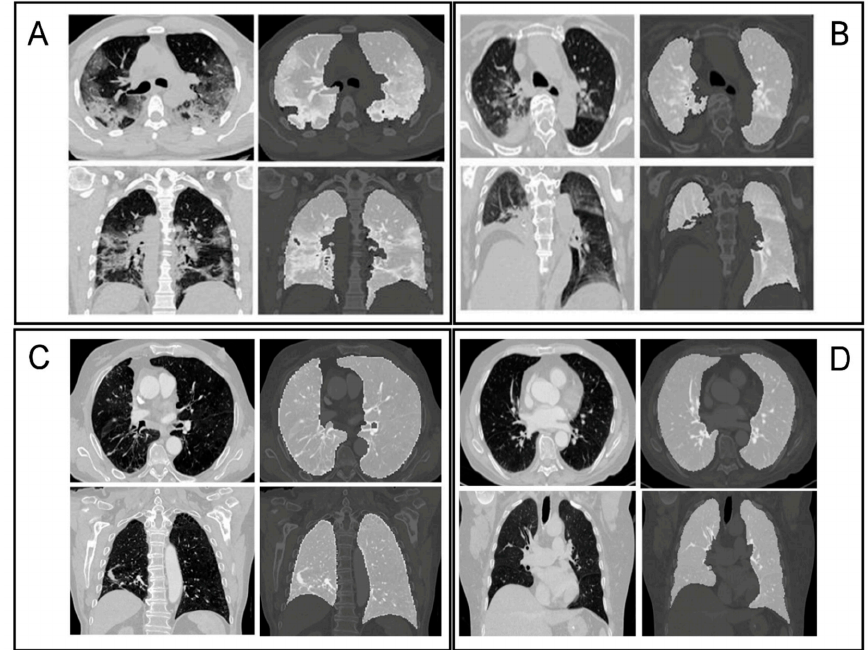
Figure 2. Axial and coronal slices with accompanying segmentation masks. ( A ) Typical aspect of COVID-19 pneumonia characterized by bilateral multilobe ground-glass opacities of periph- eral/subpleural distribution, with intralesional reticulations, presenting a “crazy paving” aspect. Subpleural atelectasis and retraction bronchiectasis, typical of organizing pneumonia can also be found; ( B ) a typical aspect of COVID-19 pneumonia, with posterior right lower lobe condensation and retraction of the ipsilateral diaphragm. Central and peripherical ground-glass opacities in right lower lobe, right upper lobe and left upper lobe; ( C ) typical chronic obstructive pulmonary disease (COPD) chest computed tomography (CT) characterized by severe centrilobular and para-septal emphysema, associated with cylindrical bronchiectasis and bronchial walls thickening. Right peripherical upper lobe tree in bud pattern seen in bronchiolitis. Middle lobe crescent-shaped atelectasis condensation; ( D ) normal chest